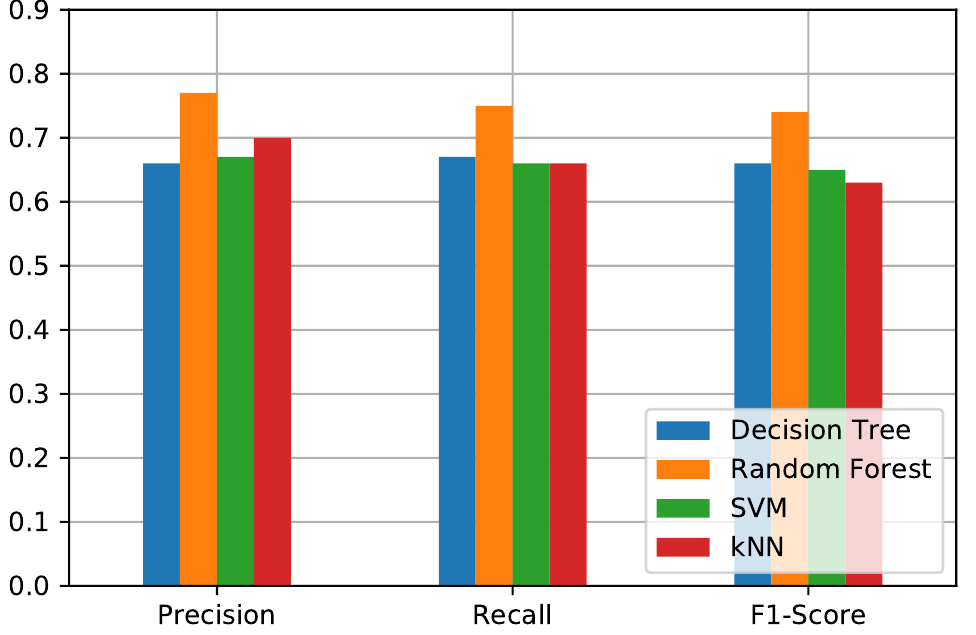
Figure 11. Q3—Precision, Recall, and F1-Score to predict the number of electrical